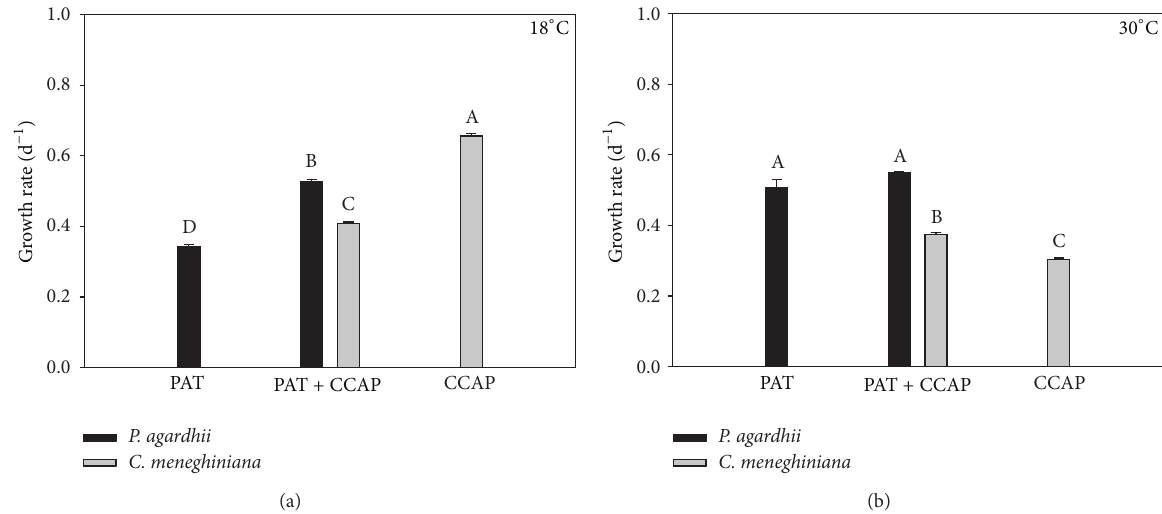
Figure 5: Chlorophyll- a -based growth rate of monocultures and mixed cultures of P. agardhii (PAT) and C. meneghiniana (CCAP) at two different temperatures (18 ∘ C and 30 ∘ C). Different letters represent significant differences at 𝑝 < 0.05 .